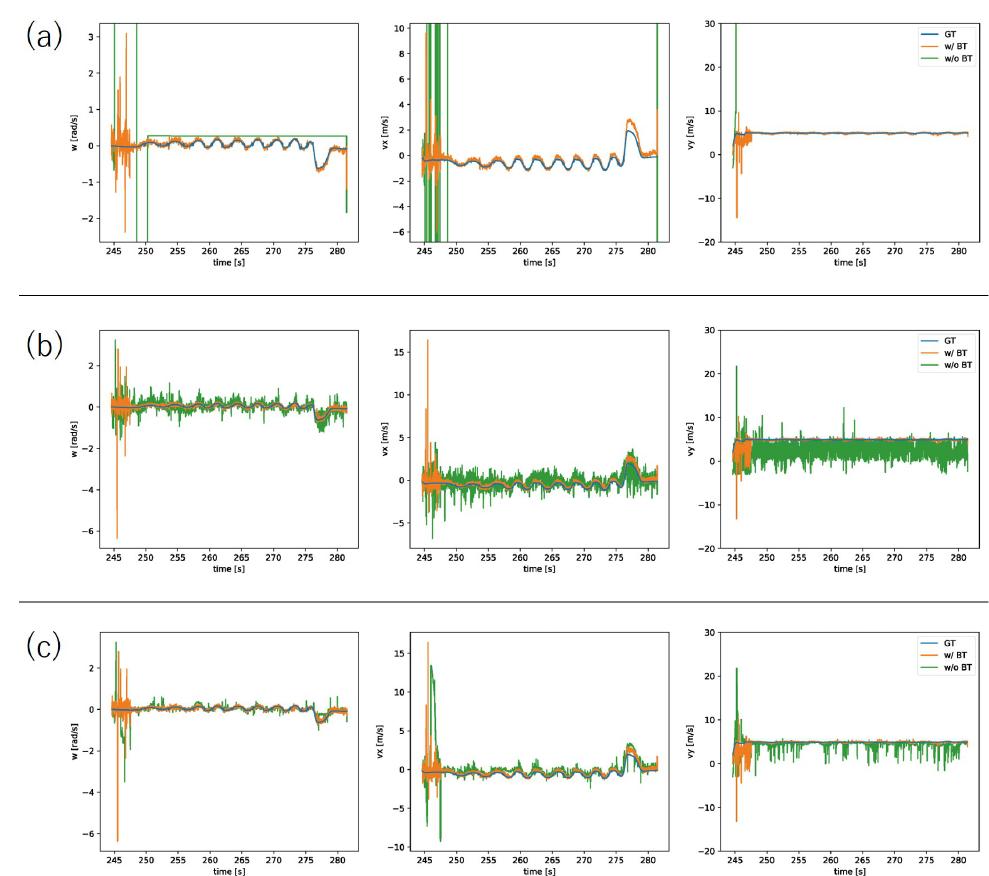
Figure 5. Results of the quantitative experiments. Blue: ground truth. Orange: proposed method with the bird’s-eye view transformation (w/BT). Green: entropy minimization method without the